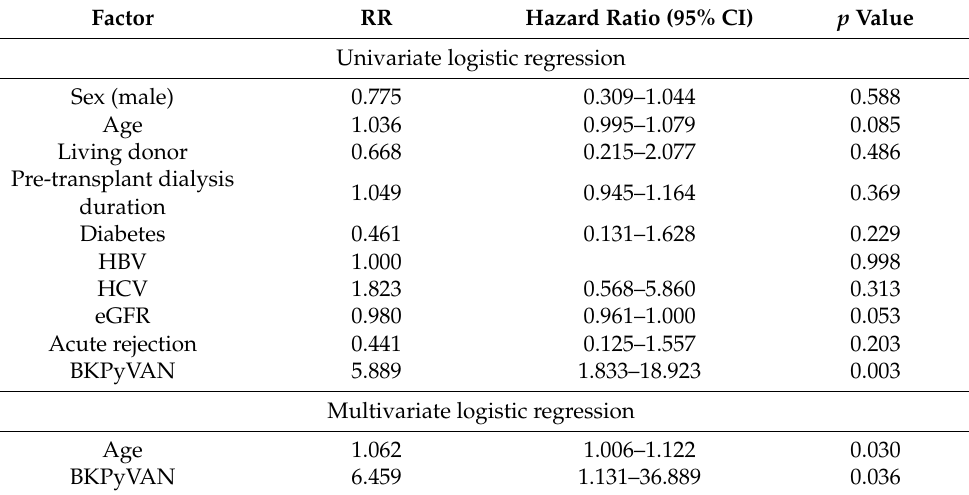
Table 3. Univariate and multivariate logistic regression analysis to identify relative risks of urinary tract cancers in kidney transplant recipients.